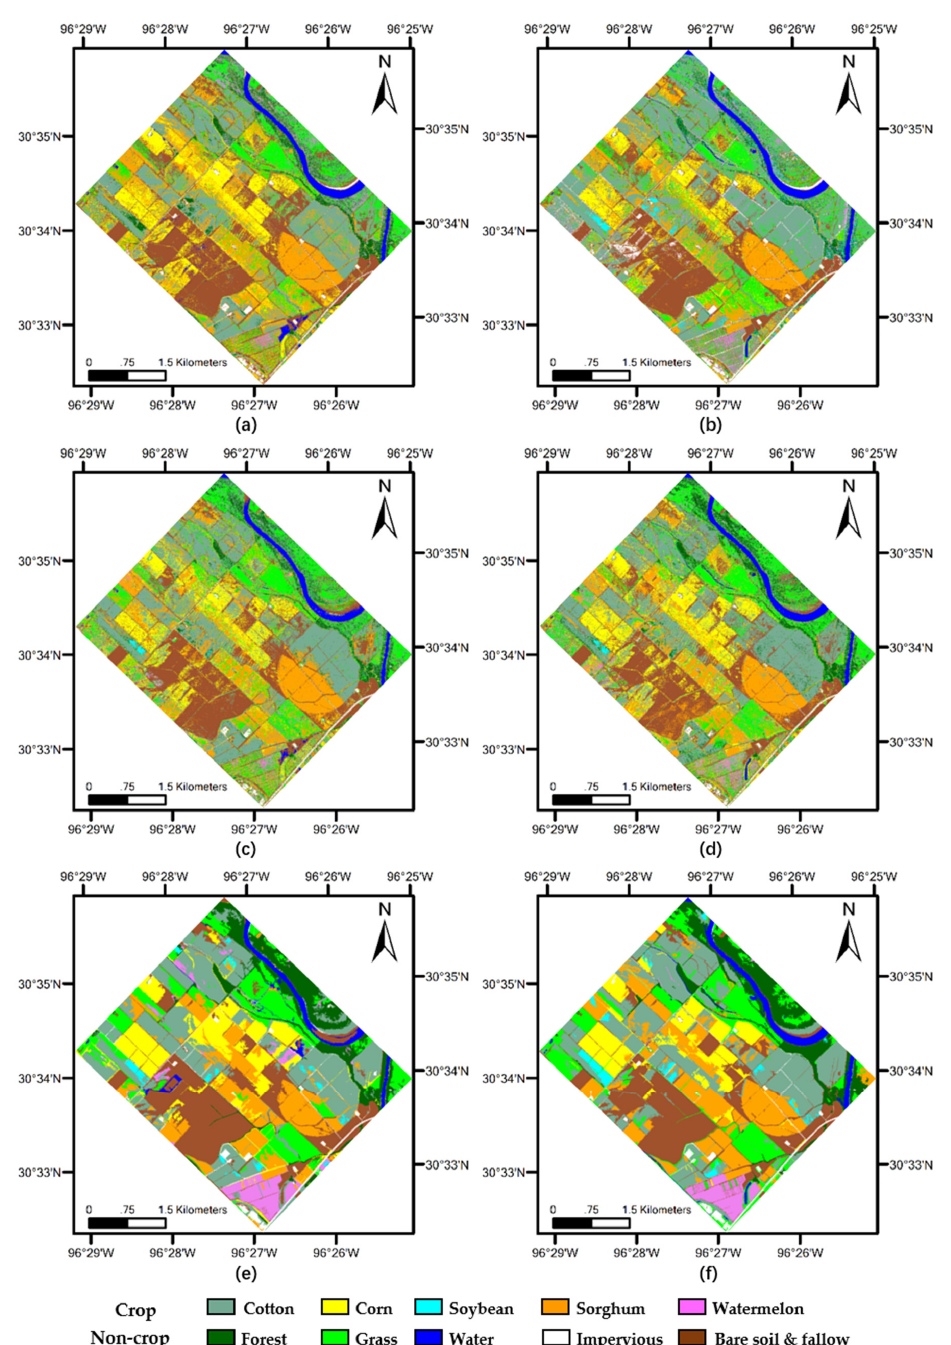
Figure 6. Image classification results (ten-class): ( a ) unsupervised classification for three-band image (3US); ( b ) unsupervised classification for four-band image (4US), ( c ) supervised classification for three-band image (3S); ( d ) supervised classification for four-band image (4S); ( e ) object-based classification for three-band image (3OB); and ( f ) object-based classification for three-band image (4OB).